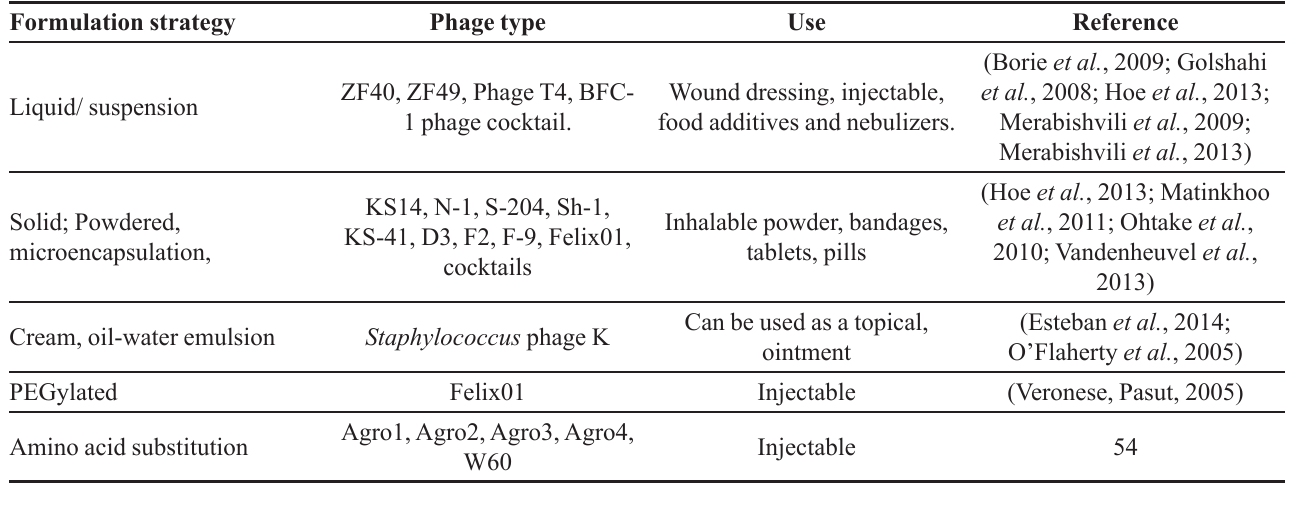
TABLE I - Phage formulation strategies Formulation strategy